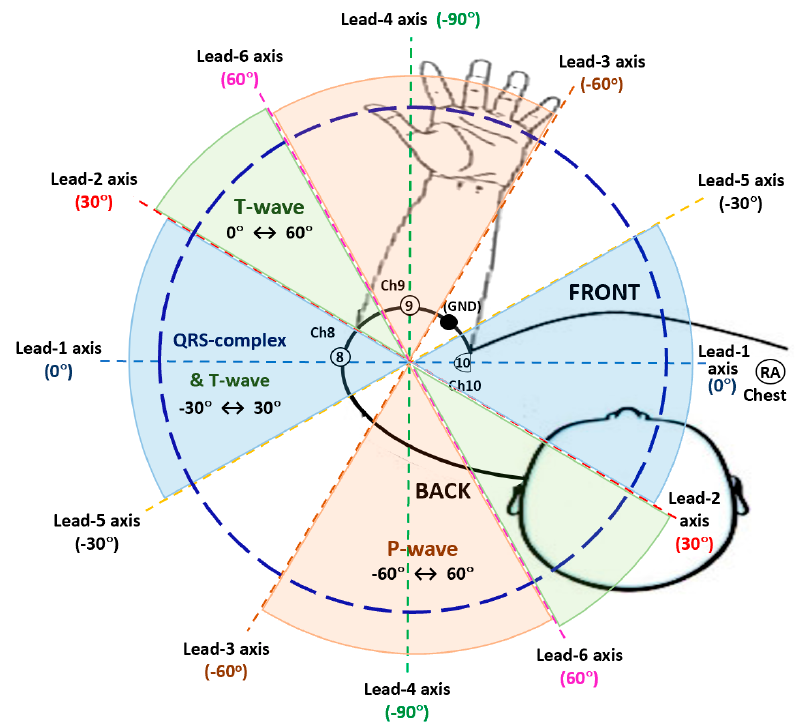
Figure 10. Bipolar arm-Lead axis angular range positions rough map for best recording of arm-ECG QRS-complex, T-wave and P-wave waveform components from an upper armband sensor (arm leads 1 to 6 are as derived from Ch8 to Ch10 and GND in Table 1).